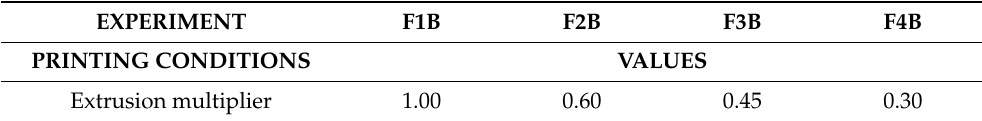
Table 3. Printing parameters of experiments F1B, F2B, F3B, and F4B.